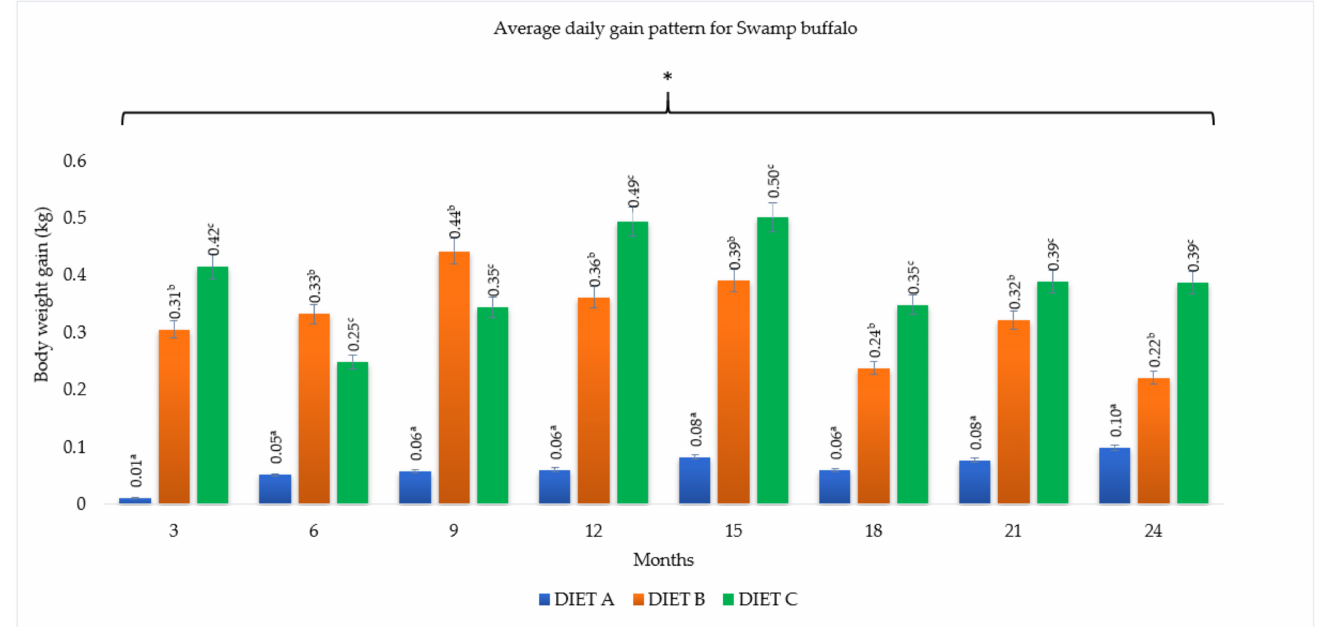
Figure 6. Effect of different diet on average daily gain at three-month intervals for Swamp buffalo. Diet A (control)—(100% Brachiaria decumbens) ; Diet B—(70% Brachiaria decumbens + 30% concentrate); Diet C—(70% Brachiaria decumbens + 26% concentrate + 4% bypass fat); the values are presented as mean; a,b,c different superscripts indicate significant difference of average daily gain pattern for Swamp buffalo at p < 0.05; * indicating significant ( p < 0.05) difference comparing body weight gain and